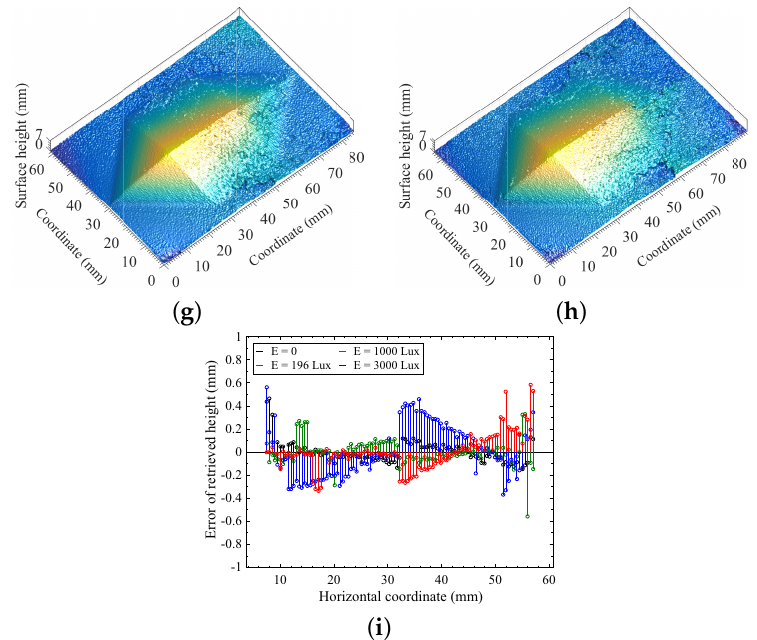
Figure 6. Measurement and reconstruction of the heptahedron-shape vulcanized silicone rubber illuminated by monochromatic sinusoidal fringe pattern at 532 nm under different background illuminance E . ( a ) Measurement of E = 0. ( b ) Measurement of E = 196 Lux. ( c ) Measurement of E = 1000 Lux. ( d ) Measurement of E = 3000 Lux. ( e ) Reconstruction using ( a ). ( f ) Reconstruction using ( b ). ( g ) Reconstruction using ( c ). ( h ) Reconstruction using ( d ). ( i ) Comparing the absolute-error distribution of retrieved surface height on the cross section perpendicular to the ridge with actual values based on the data in ( e – h